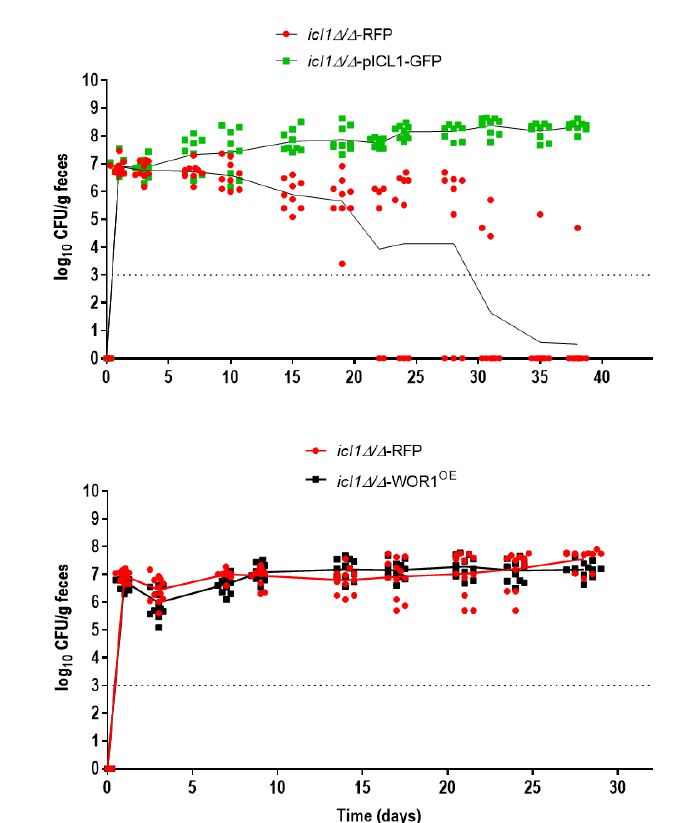
Figure 5. Gastrointestinal colonization of icl1 Δ / Δ mutants. Oral antibiotic therapy was given to mice starting 4 days before inoculation by gavage of 10 7 cells of a 1:1 mixture of icl1 Δ / Δ -RFP and icl1 Δ / Δ -pICL1-GFP ( n = 9) ( A ) or icl1 Δ / Δ -RFP and icl1 Δ / Δ -WOR1 OE ( n = 12) ( B ). The dotted line indicates the limit of detection of the method used.